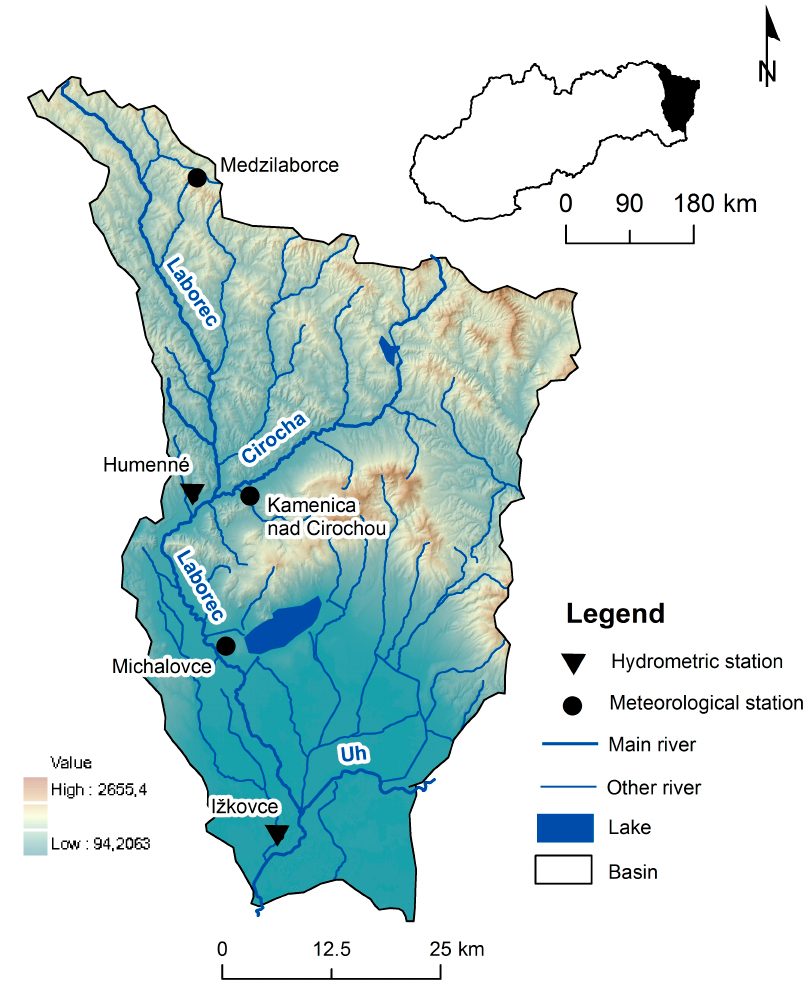
Figure 1. Study Figure 1. Study area.